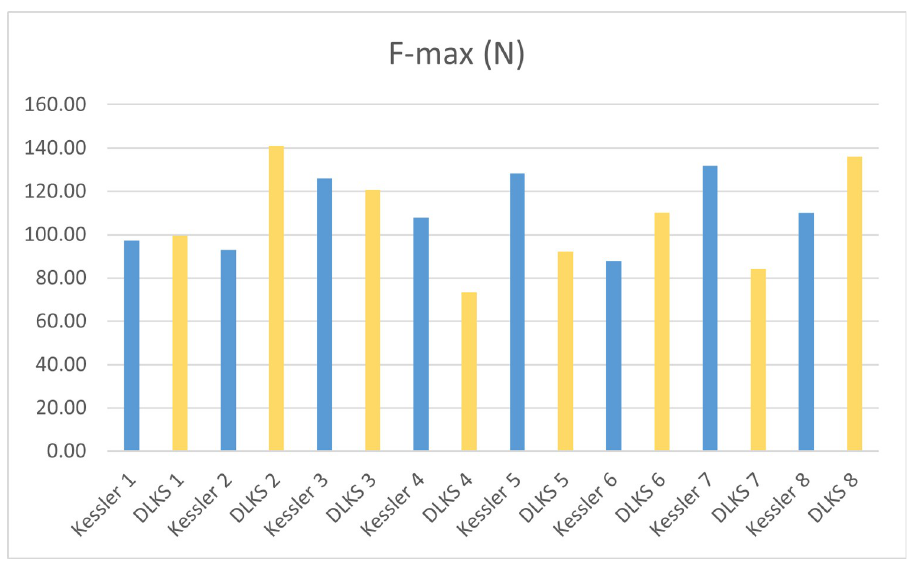
Fig 5. Single values from ultimate load to failure